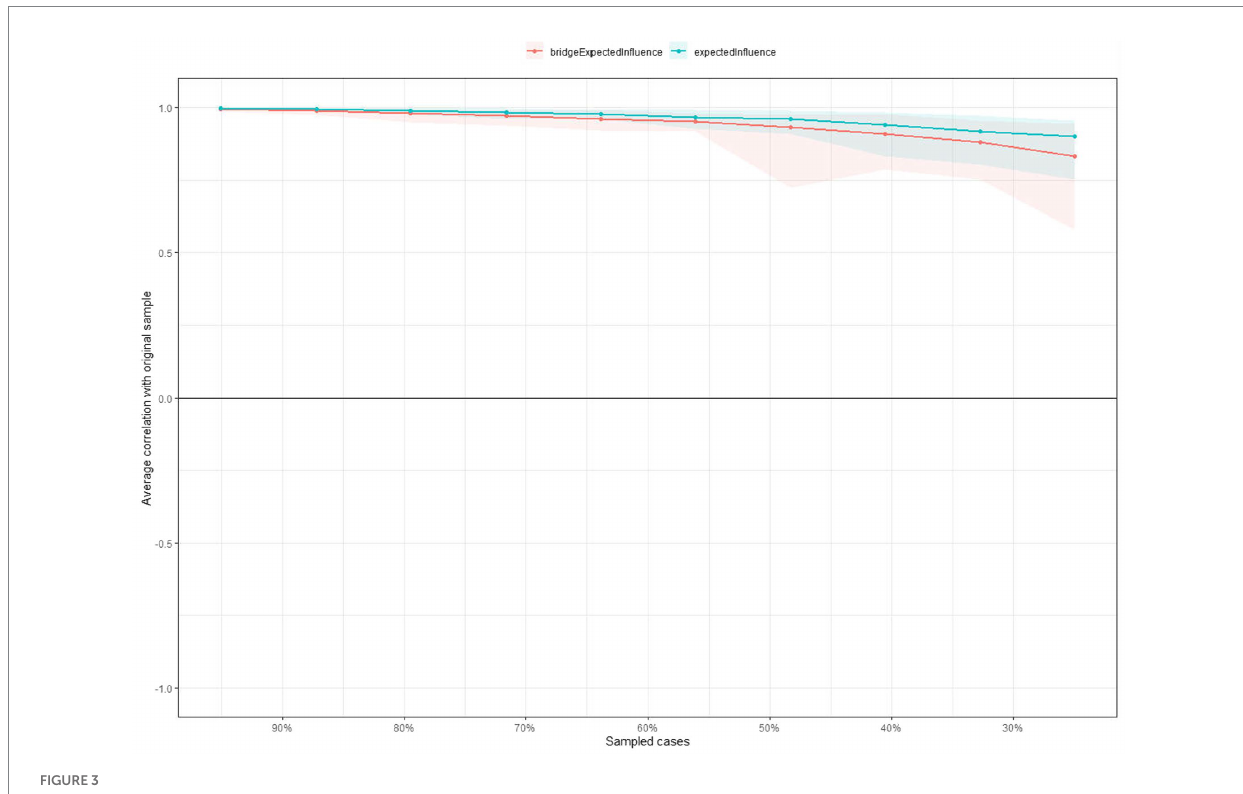
FIGURE 3 Centrality and bridge centrality indices